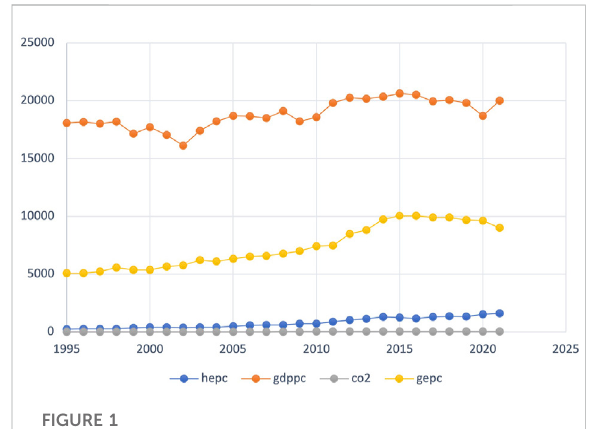
FIGURE 1 Relationship between CO2 emissions, Economic Growth (GDPPC),HealthExpenditure(HEPC)andGreenEnergy(GEPC)for the period 1995 –